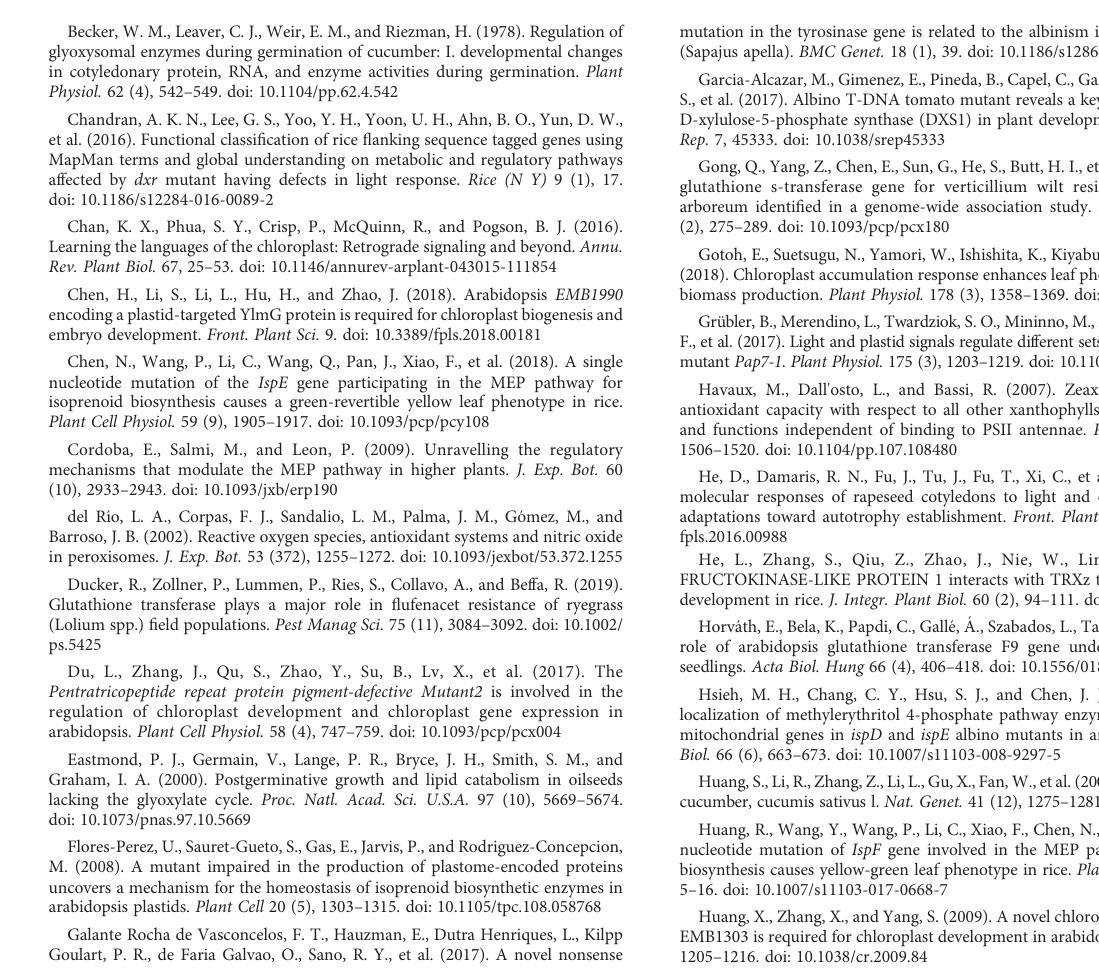
Histogram of GO enrichment